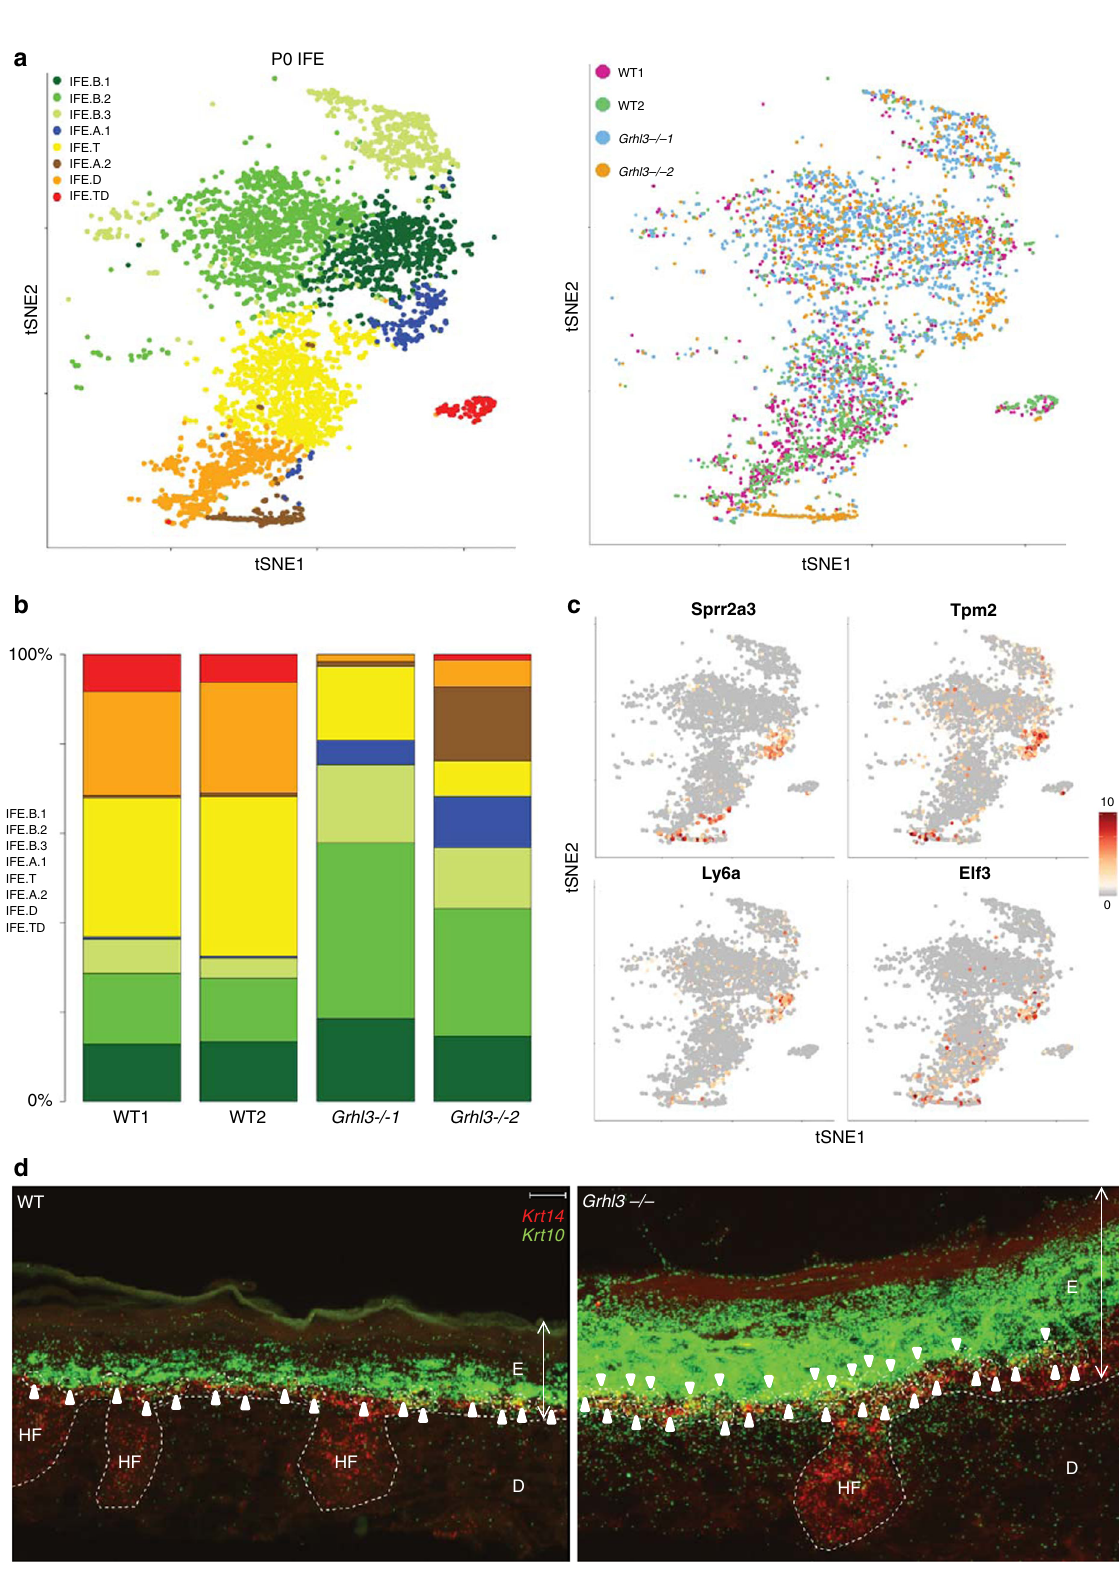
Fig. 4 GRHL3 is required for suppressing aberrant basal IFE stem cells. a tSNE plot showing WT and Grhl3 − / − P0 IFE cells colored by clusters (left) and genotype (right). b Bar plot showing the fraction of each IFE cell type in each sample. There is expansion of basal cells and reduction of differentiated/ terminally differentiated cells in Grhl3 − / − IFE. c Gene expression levels of markers for the IFE.A1 population. Sprr2a3, Tpm2, Ly6a and Eif3 are shown on a tSNE plot of the P0 IFE cells. d Representative RNA-FISH of Krt14 and Krt10 transcripts in P0 WT and Grhl3 − / − mouse epidermis; white arrows highlight Krt14 / Krt10 double-positive transition cells. Note the higher number of double-positive cells in the Grhl3 − / − epidermis; also some transition cells are found in the spinous layer. N = 5. White broken line, basal lamina; E epidermis, D dermis, HF hair follicle. Scale bar = 10 µ